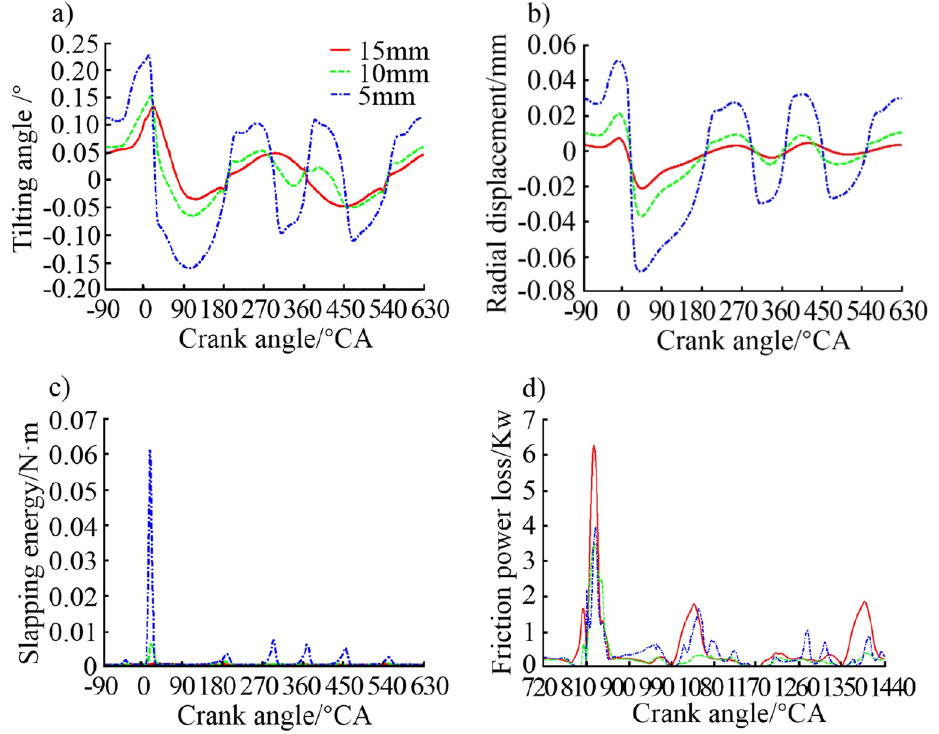
Figure 12. Effect of skirt ovality on ( a ) piston tilting angle, ( b ) piston radial displacement, ( c ) piston slapping energy, and ( d ) piston friction power